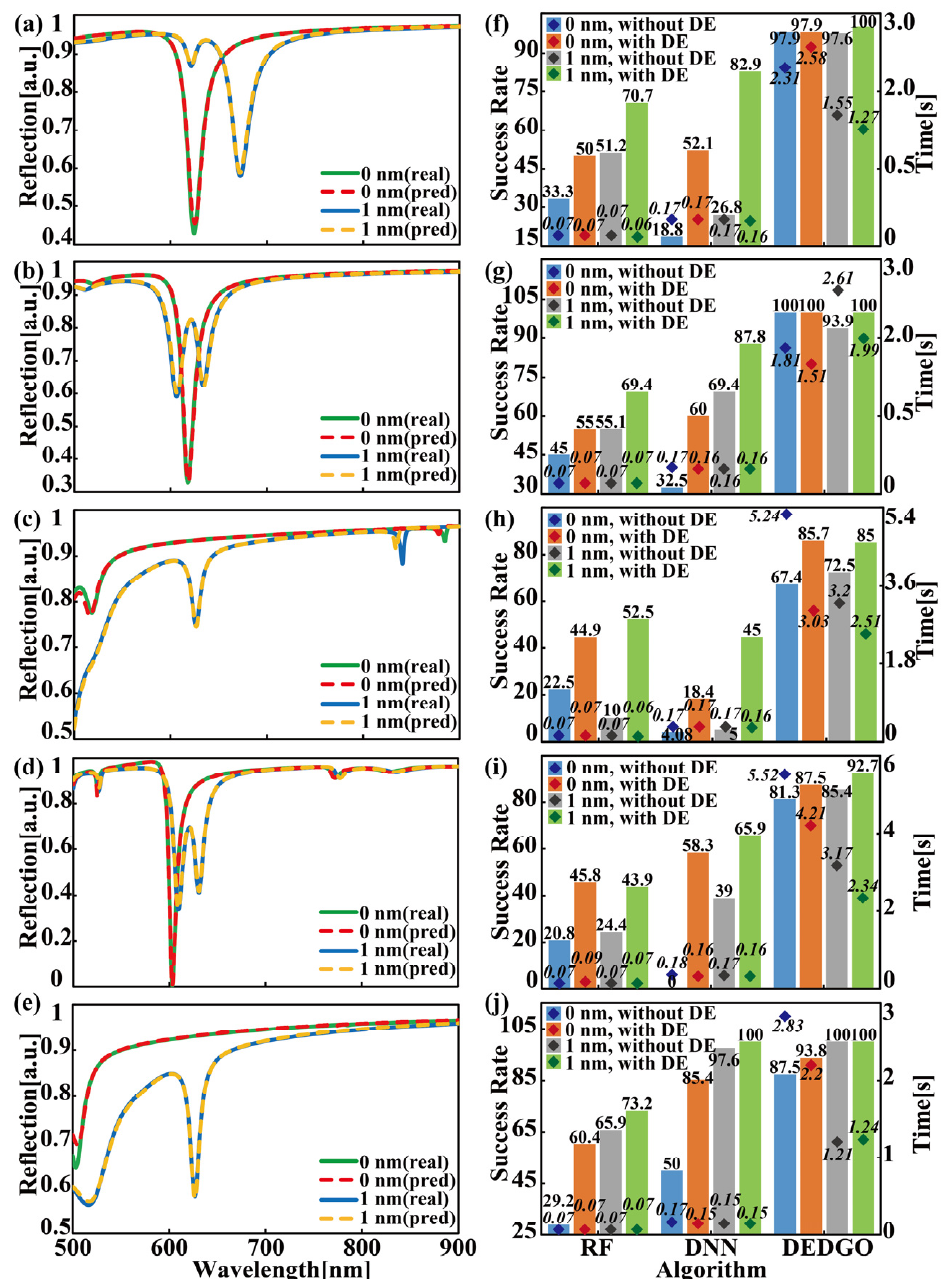
Figure 5. Typical results of inverse design with the DEDGO algorithm. ( a – e ) Spectral comparison of true (real, solid lines) and predicted values (pred, dotted lines) for S1–S5 heterojunctions (1 nm) and their pure cavity counterparts (0 nm). ( f – j ) The predicted success rate and time consumption for samples in different categories based on the DEDGO algorithm. ( a – e ) Concretely, the MAPE of the spectra are shown as follows: S1: 0 nm, 0.22; 1 nm, 0.23; S2: 0 nm, 0.24; 1 nm, 0.22; S3: 0 nm, 0.18; 1 nm, 0.25; S4: 0 nm, 0.22; 1 nm, 0.24; S5: 0 nm, 0.21; 1 nm, 0.24. Notably, the 0 nm thickness for the WS 2 film indicates the case of a pure photonic cavity, unless otherwise specified.